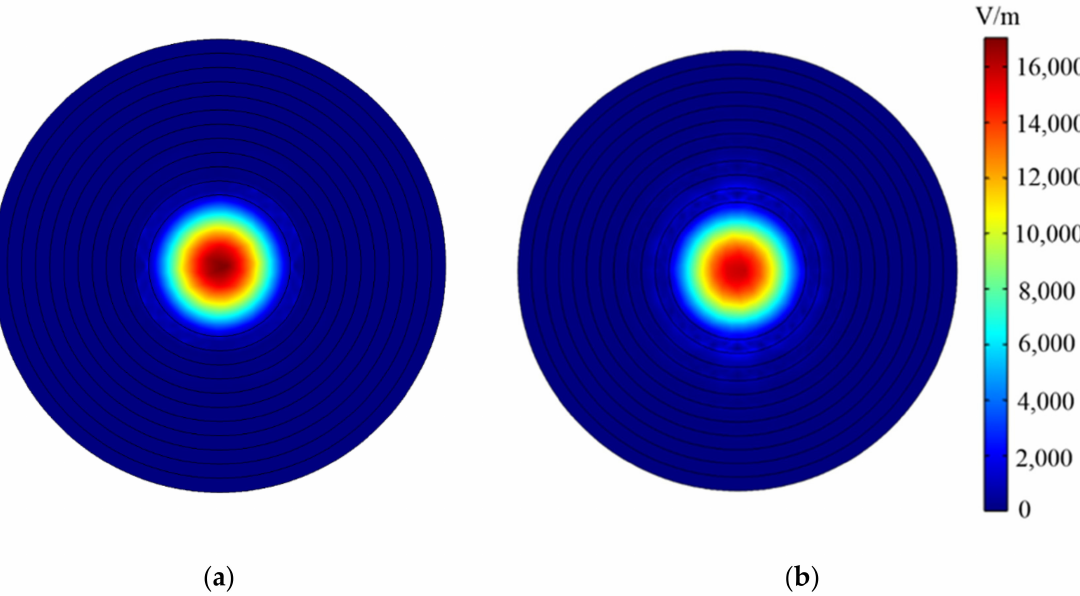
Figure 3. ( a ) The electric field distributions of the fundamental mode with water at 280 K ( b ) and without water at 0.45